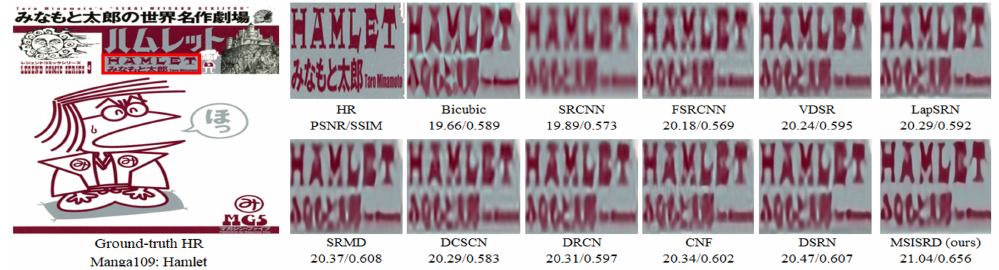
Figure 13. Visual performance of the image “Hamlet” from Manga109 [64] dataset with 8 × scale factor enlargements